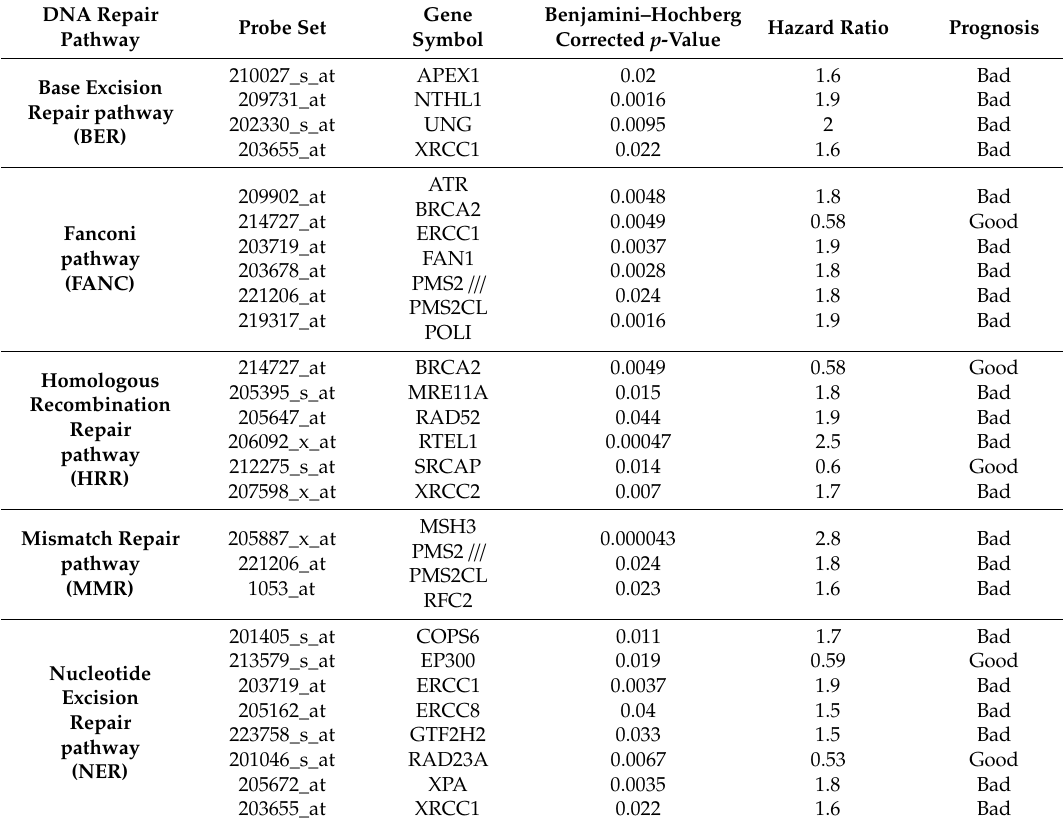
Table 1. List of the 23 probe sets associated with good or bad prognosis in cytogenetically normal acute myeloid leukemias (CN-AML). Corresponding DNA repair pathway, gene symbol, adjusted p-value, hazard ratio, and prognosis significance are provided for each